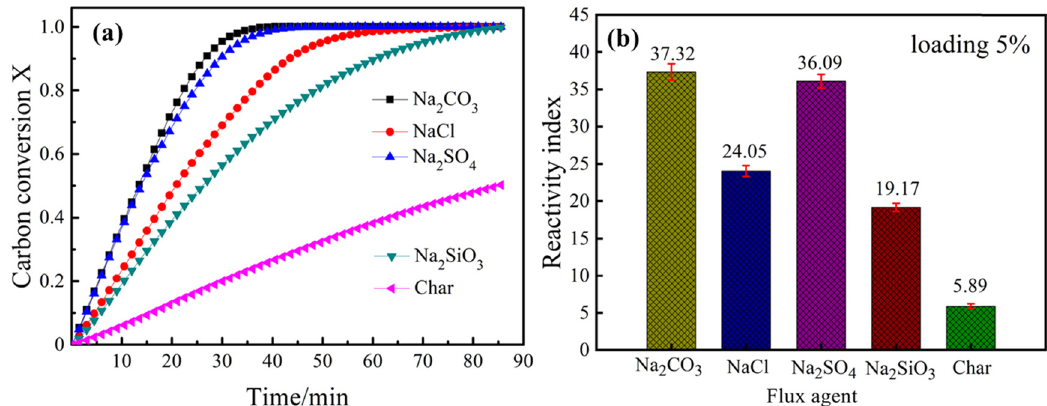
Figure 2: E ff ect of Na - based fl ux agents on the reactivity of ZJX char: ( a ) gasi fi cation rate and ( b ) gasi fi cation reactivity